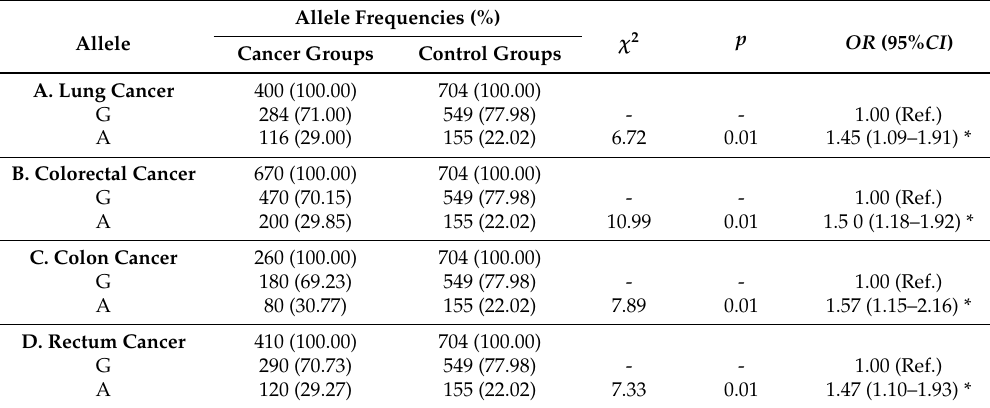
Table 5. LOX G473A allele frequency distribution in tested